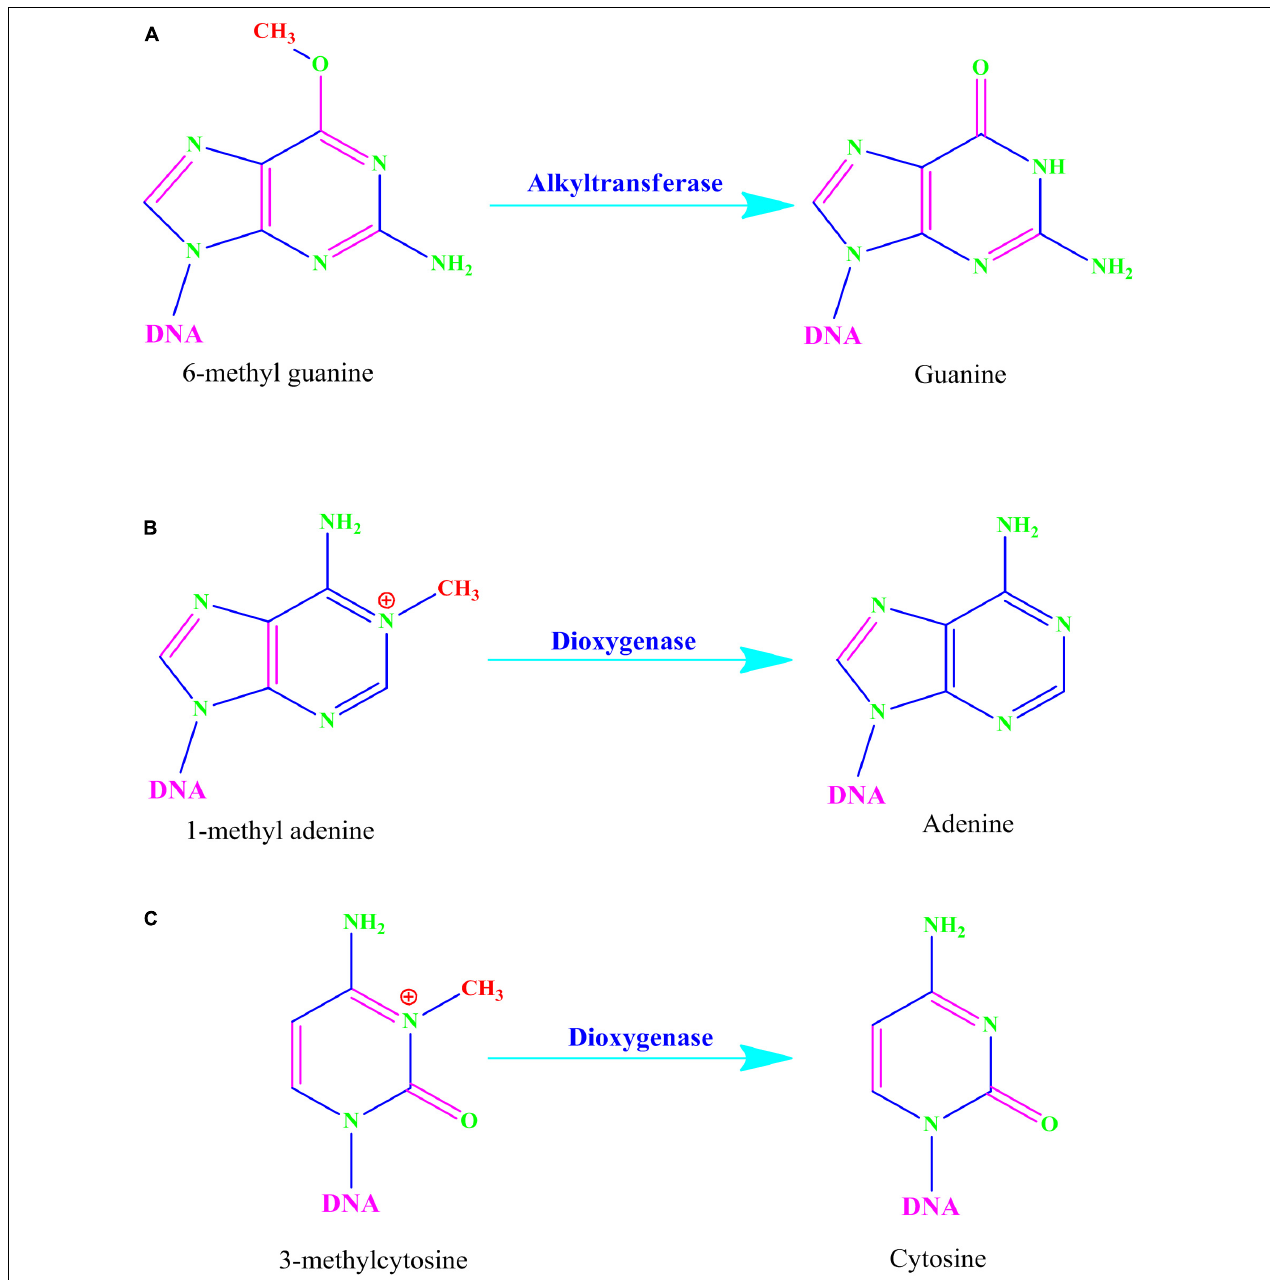
FIGURE 3 | (A) Alkyltransferase mediated direct reversal of 6 methyl guanine to guanine. (B) Dioxygenase-mediated direct reversal of 1 methyl adenine to adenine. (C) Dioxygenase-mediated direct reversal of 3 methylcytosine to cytosine. Source: Figure adapted and modified from Yi and He